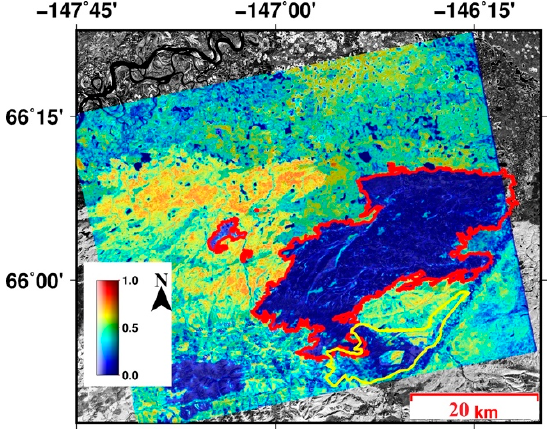
Figure 2. ALOS coherence estimate between 17 July 2007 and 6 September 2009 (path 252). Note near zero values over the fire scare, which indicates complete loss of InSAR